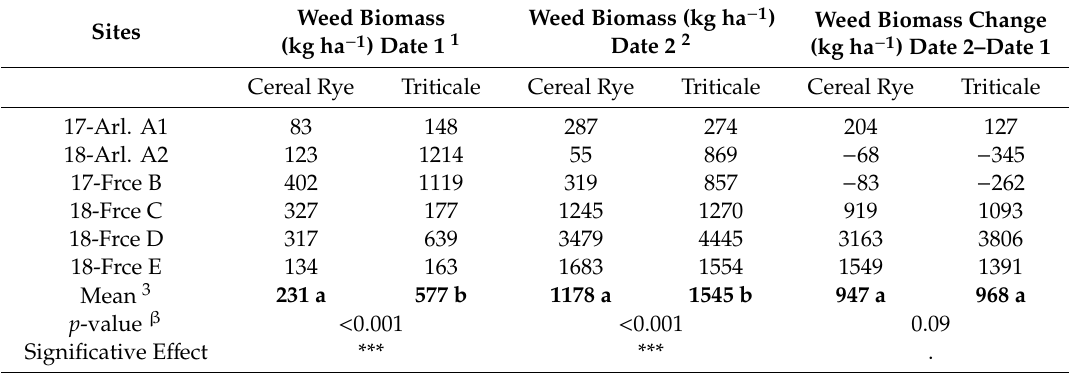
Table 3. Summer and fall weed biomass from the two cover crop treatments over the six sites, 2017 and 2018. Weed biomass changes between the two dates, indicative of the degree of weed growth, are also